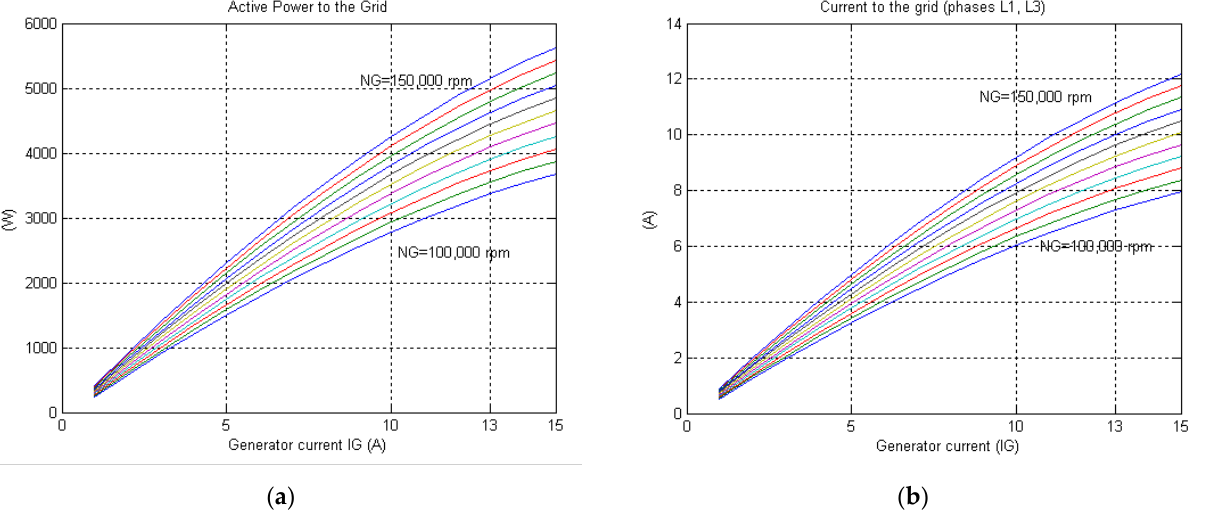
Figure 9. ( a ) Calculated power to the grid as a function of the Generator Current IG varying the MGT speed from 100 to 150 krpm; ( b ) Calculated current injected to the grid a function of the Generator Current IG varying the MGT speed from 100 to 150 krpm.